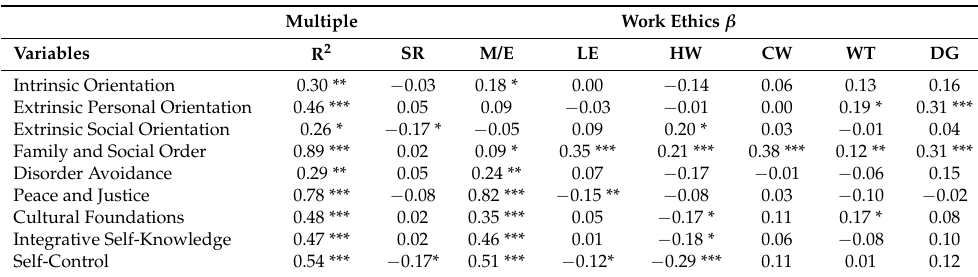
Table 4. Multiple Regression Results with Work Ethics Measures Predicting Religious Orientations, Integrative Self-Knowledge, and Self-Control. Multiple Work Ethics β Variables